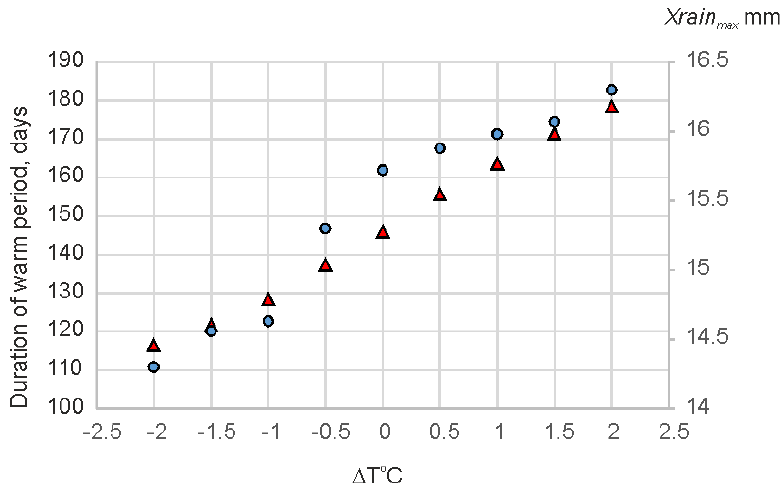
Figure 18. Changes in the duration of the warm period ( triangles ) and in the mean daily runoff maximum ( circles ) with variations of daily air temperatures.